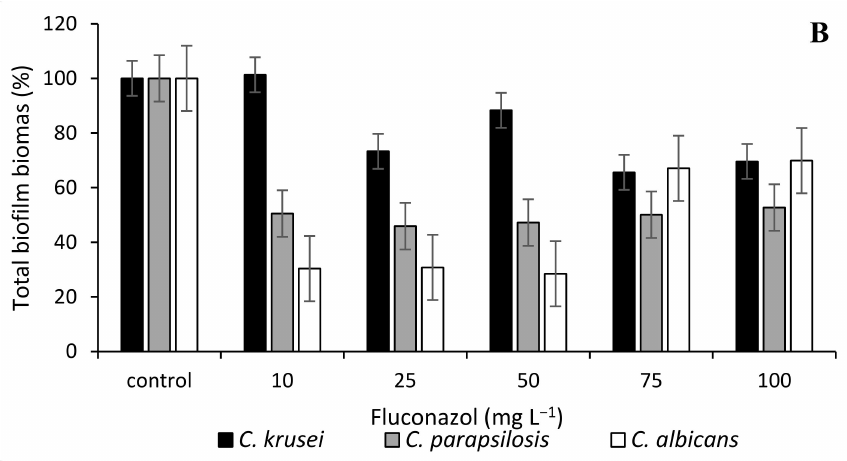
Figure 2. Effect of fluconazole on C. albicans ATCC 2091, C. parapsilosis CCM 8260 and C. krusei CCM 8271. Biofilm metabolic activity of ( A ); total biofilm biomass ( B ); control 100% (no agent). Error bars represent standard